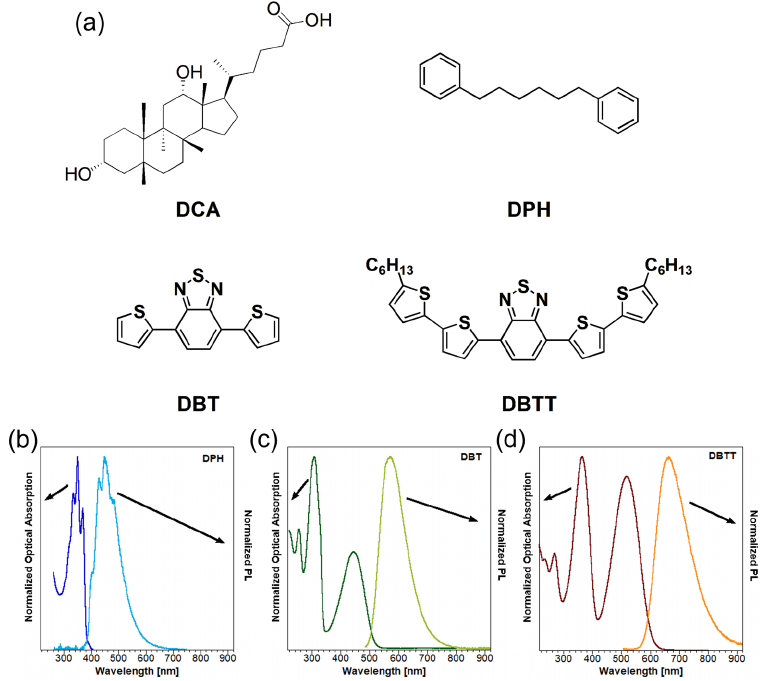
Figure 1. ( a ) Chemical structures of DCA, DPH, DBT and DBTT. Absorption and photoluminescence spectra of ( b ) DPH in MeOH and ( c ) DBT and ( d ) DBTT in THF, with excitation wavelengths at 360 nm, 420 nm and 500 nm, respectively.